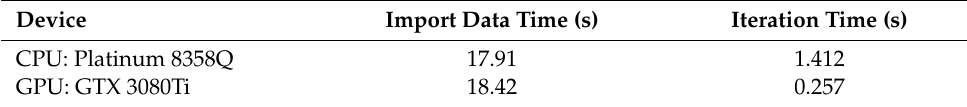
Table 1. CPU and GPU speed comparison.